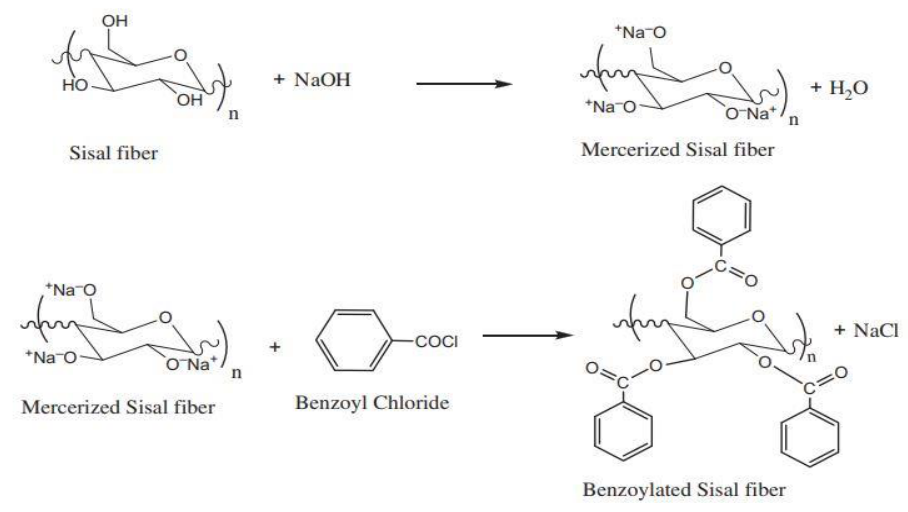
Figure 3. Reactions involved in benzoylation treatment with sisal fibers (Reprinted from permission from [72]. Copyright 2021 Copyright Taylor & Francis).